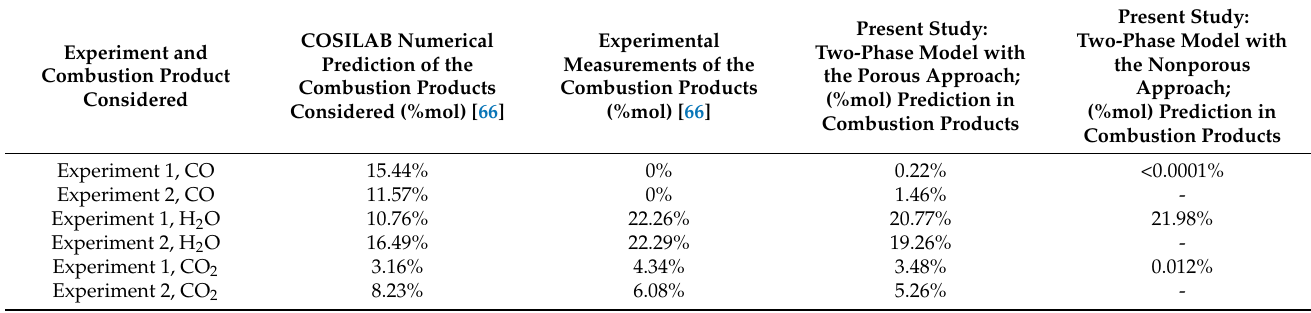
Table 4. Comparison of the prediction of species concentration (%mol) in combustion gas products. Numerical prediction, experiments and the present model.